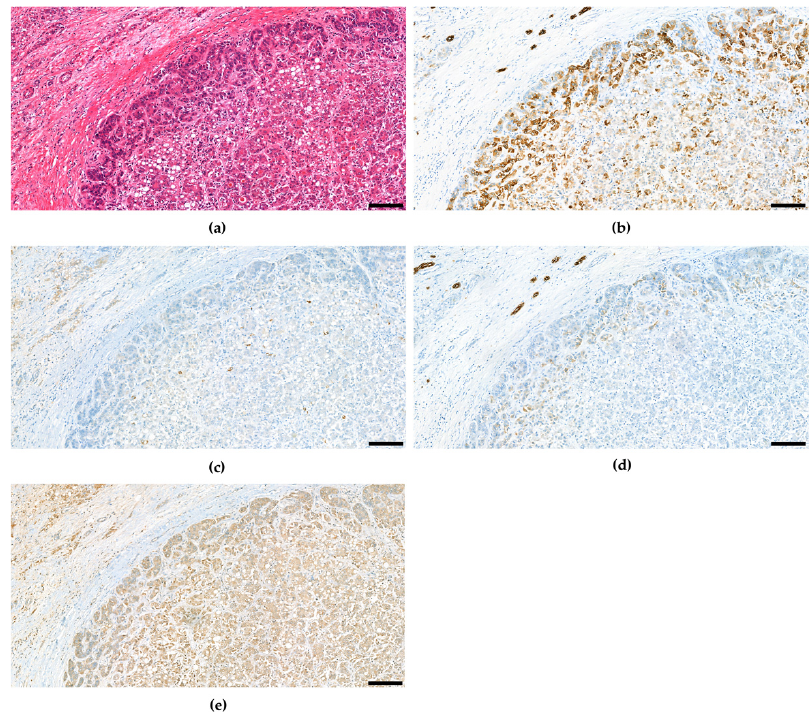
Figure 3. Combined hepatocellular and cholangiocellular carcinoma, transitional zone elements and intermediate cell features. CD56 and c-Kit were not expressed (not shown). ( a ) H&E. ( b ) CK7. ( c )